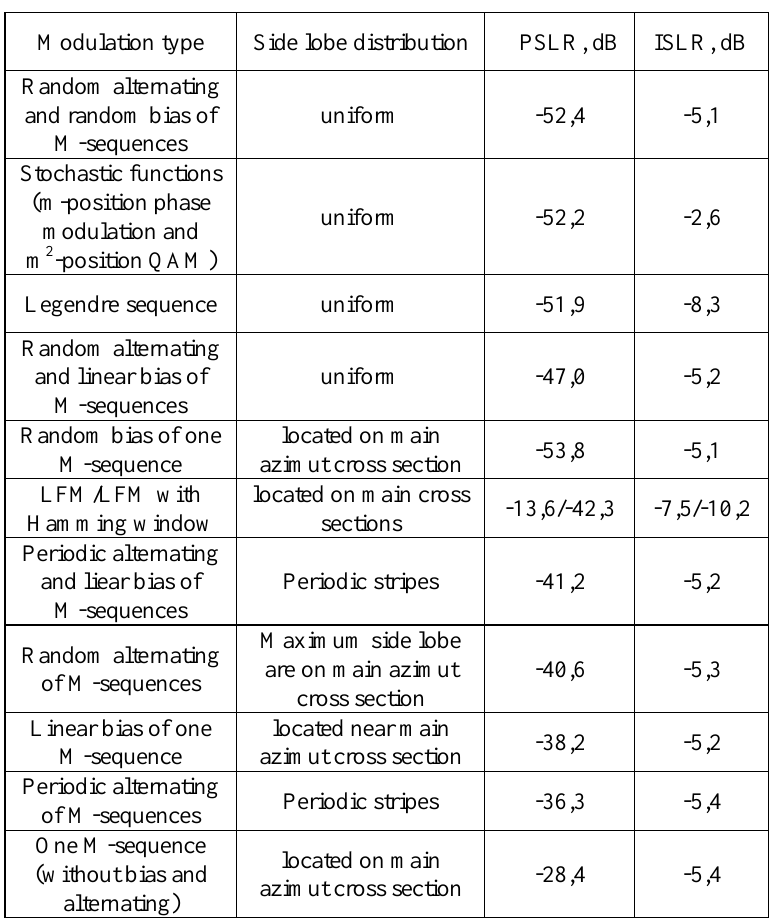
Table 1. Modulation functions and characteristics provided by